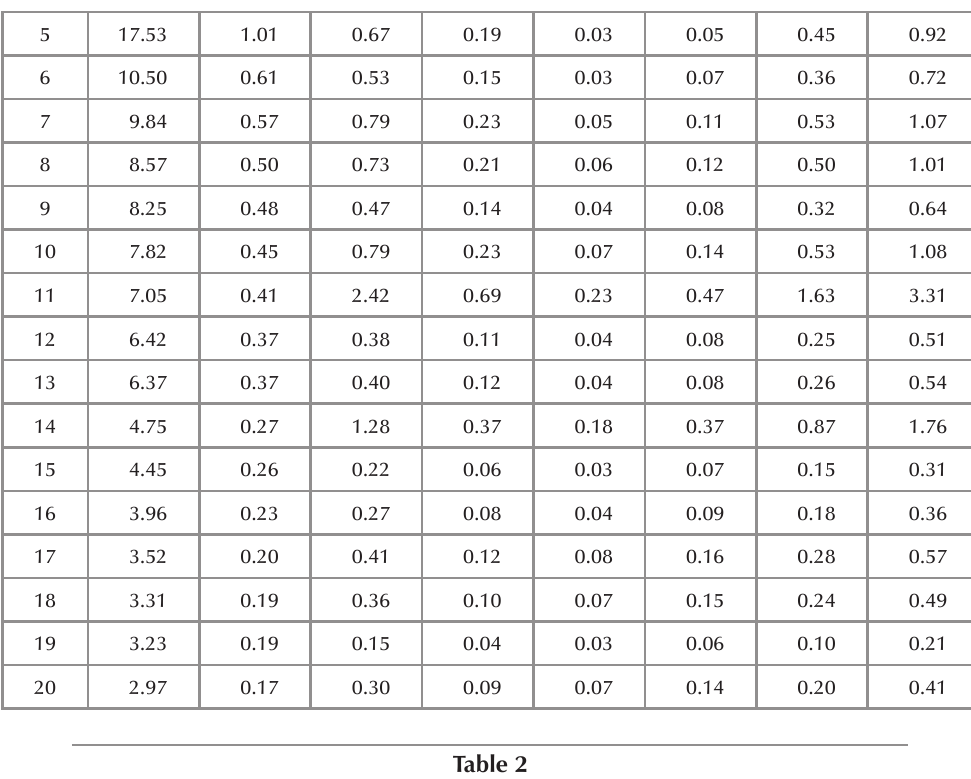
Calculated minimum and maximum CO